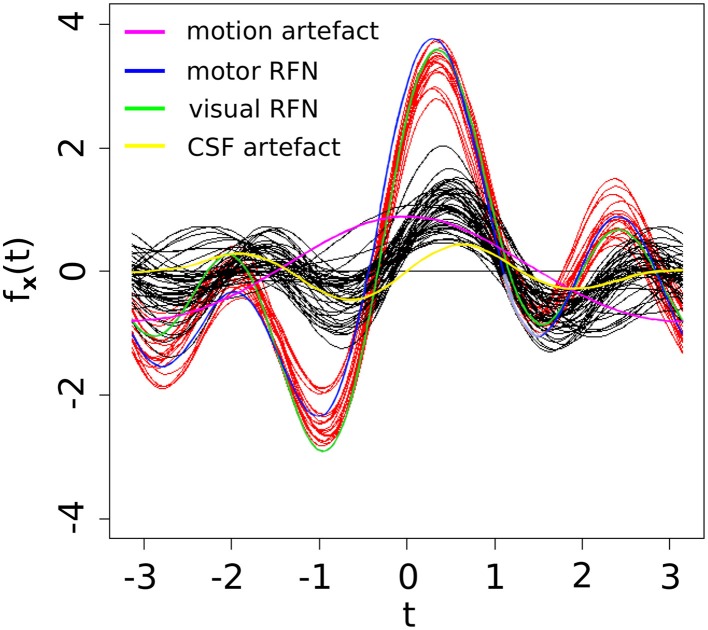
Visually inspected ICs in feature space visualized using Andrew's curves. Selected feature space consists of only the significant (p < 0.01) features. Red curves represent class RFN and black curves represent class ART.